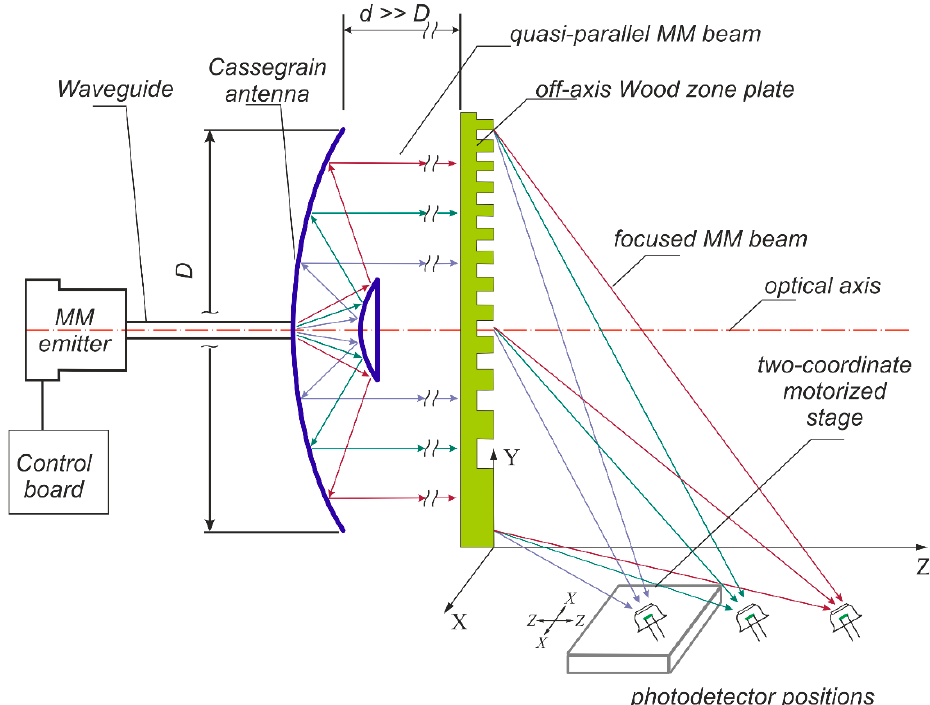
Figure 1. Experimental setup. The MM emitter, waveguide, Cassegrain antenna, and Wood zone plate are mounted on an optical rail (not shown) and on a single optical axis. The two-coordinate motorized stage with a pyroelectric detector in its center is installed horizontally so that the radiation focus coincides with the photosensitive area of the pyrodetector.